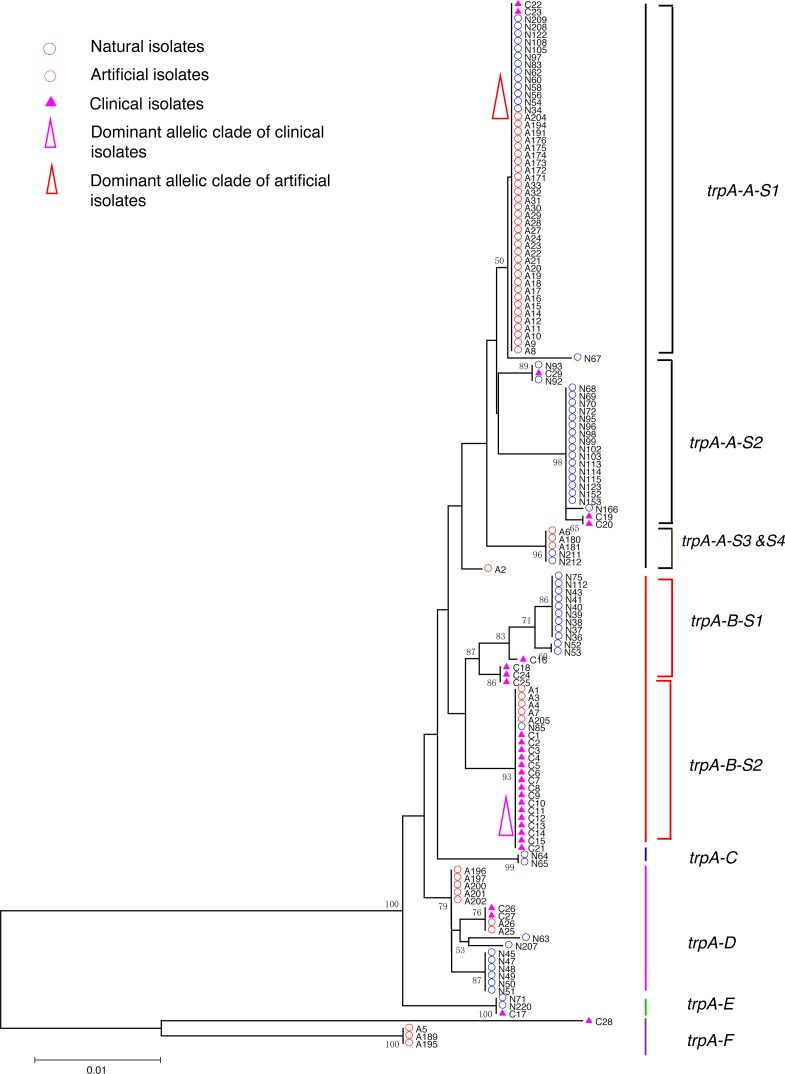
Neighbor-Joining tree of L. pneumophila isolates from DNA sequences of trpA locus.Strain types, source natures and geographic locations of these isolates were shown in Table S1. Bootstrap support values (1,000 replicates) for nodes higher than 50% are indicated next to the corresponding node. Six main groups of the clades could be found.